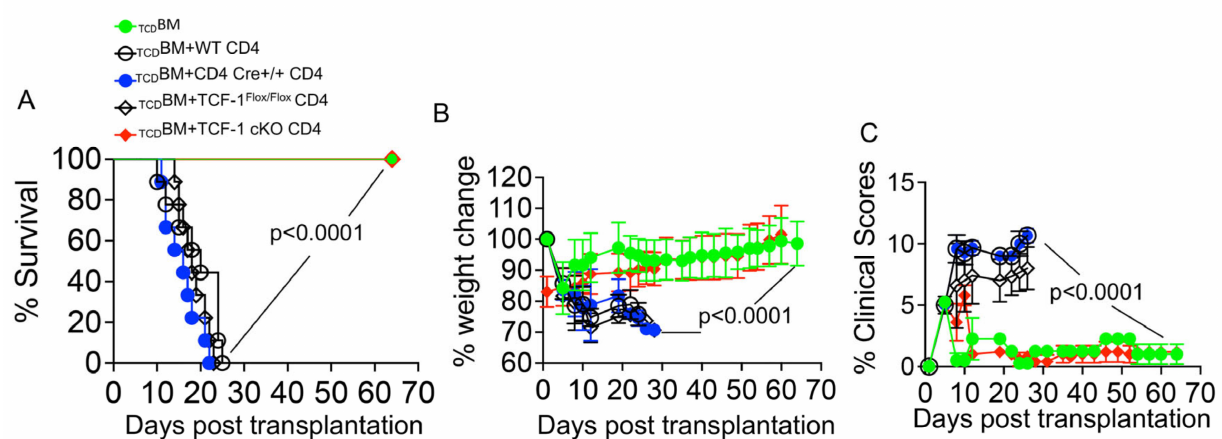
Figure 2. Loss of TCF-1 in donor CD4 T cells reduces severity and persistence of GvHD symptoms. Recipient BALB/c mice (MHC haplotype d) were lethally irradiated and allotransplanted with 10 × 10 6 WT C57Bl/6 TCD BM cells and 1 × 10 6 CD4 T cells from WT, CD4cre+/+, TCF-1 Flox/Flox or TCF-1 cKO donor mice (C57Bl6 background, MHC haplotype b). The mice were weighed and given a GvHD clinical score three times per week for almost 70 days. Score was determined by the combined scores for fur texture, activity level, posture, skin integrity, weight loss, and diarrhea. ( A ) Survival of mice in each group over the 70 day experiment, analyzed with Kaplan–Meier survival statistics. ( B ) Changes in weight, as determined three times a week over 70 days. ( C ) Clinical scores were determined three times a week over 70 days. Mean and SD plotted, analyzed by one-way ANOVA. n = 4 mice/group for BM alone: n = 5 experimental mice/group for all other groups. Survival is a combination of two experiments. Each experiment is repeated